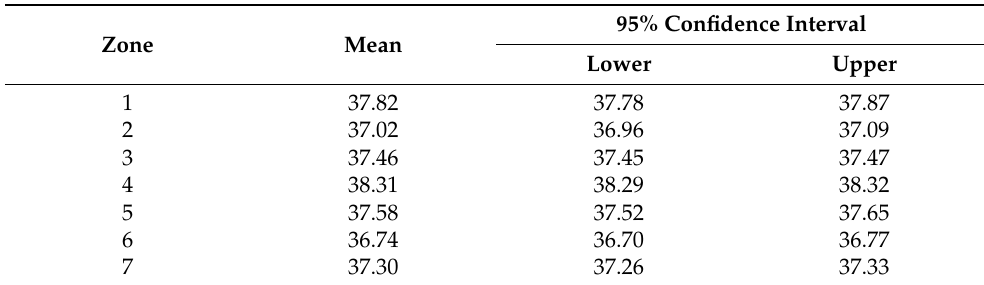
Table 3. The mean temperature (degrees centigrade) and 95% confidence interval for zones 1–7 (see Table 1 for definitions) for both hindlimbs on three dairy farms in Morogoro ( n = 170). Zone